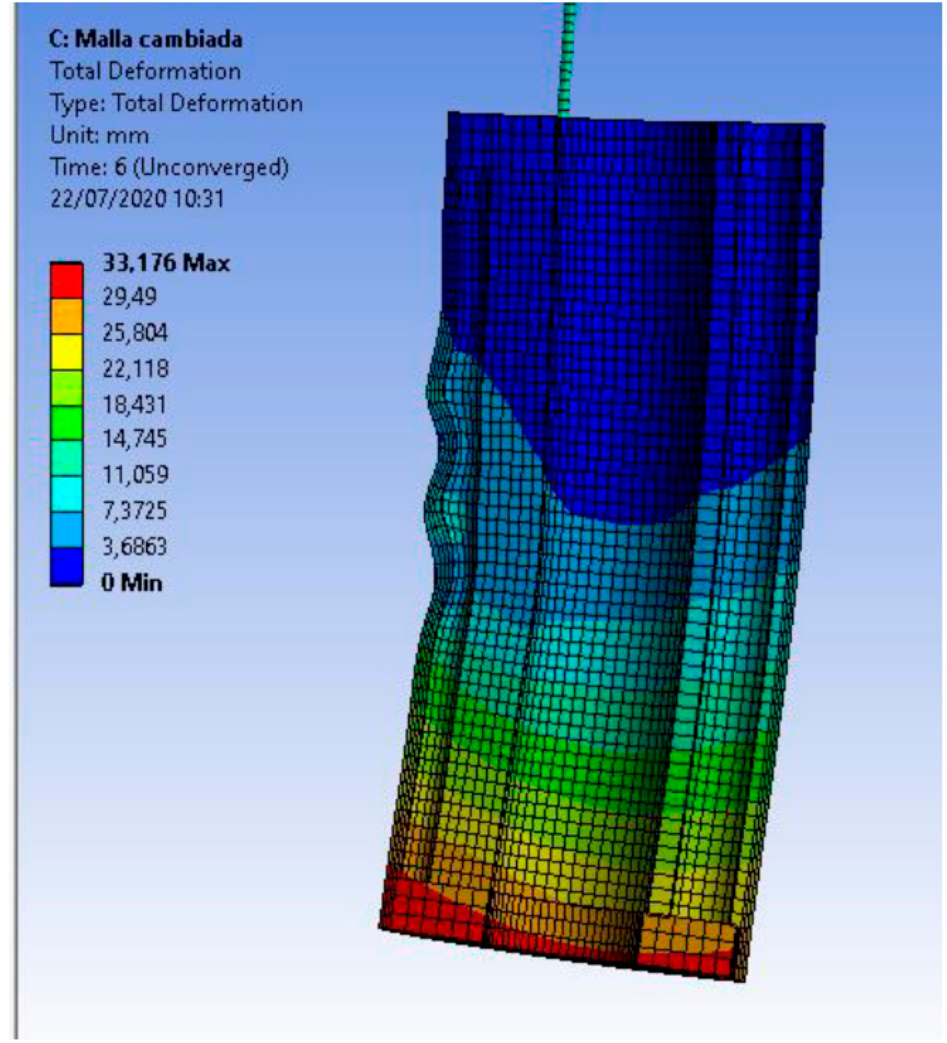
Figure 14. Simulation of the segment with folds. Source: authors.